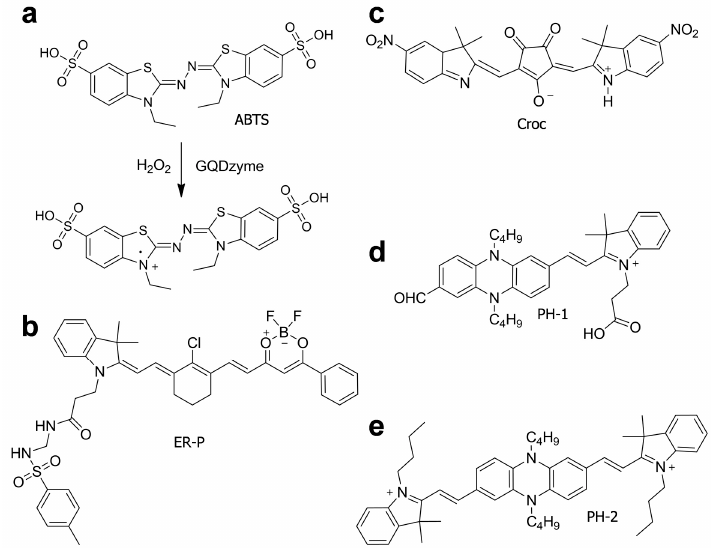
Figure 11. Chemical structures of small-molecule agents for NIR-I photoacoustic imaging.